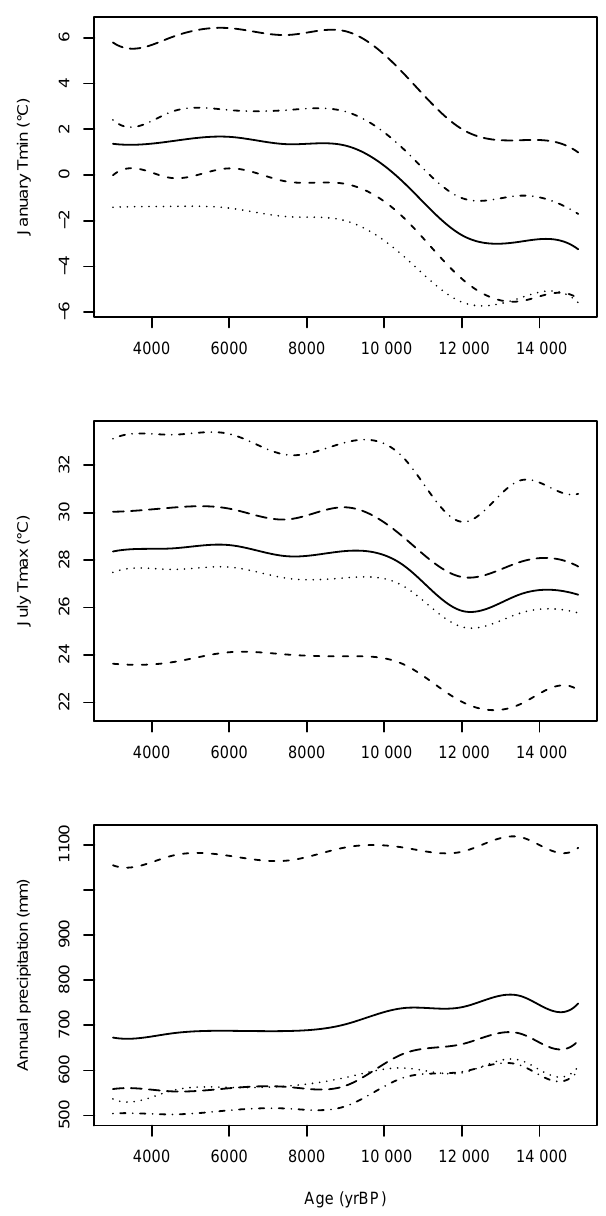
Figure 4. Minimum and maximum temperatures of January and July, respectively, and annual precipitation during the last 15kyr. The solid line represents the average climate in the study area. The remaining lines are the average of each cluster found – C1: short- dash line; C2: dotted line; C3: dash-dot line; and C4: long-dash